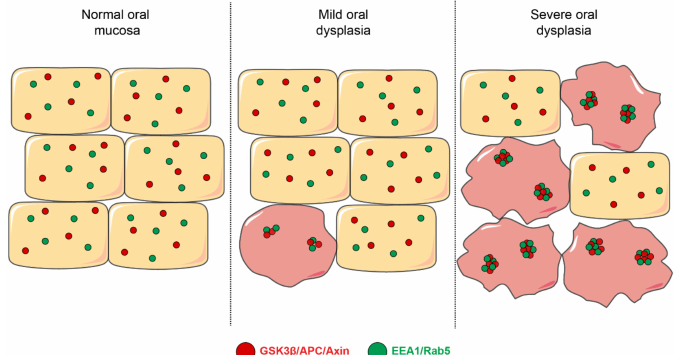
Figure 4. Early endosomes and their colocalization with components of the β -catenin